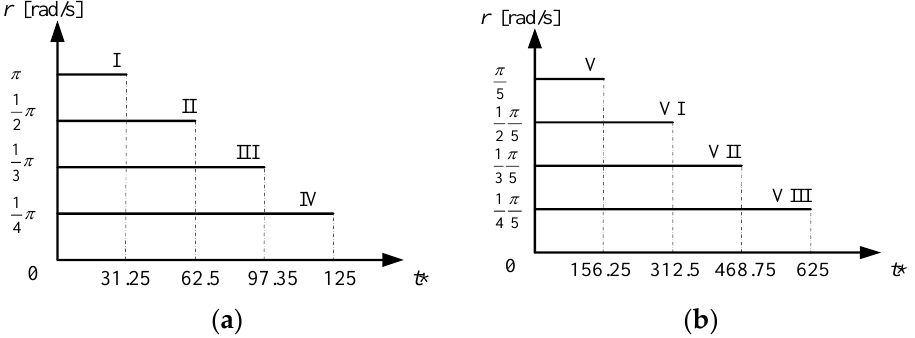
Figure 7. Schematic diagram of the relationship between speed and dimensionless time under different valve closing times: ( a ) first group. ( b ) second group.